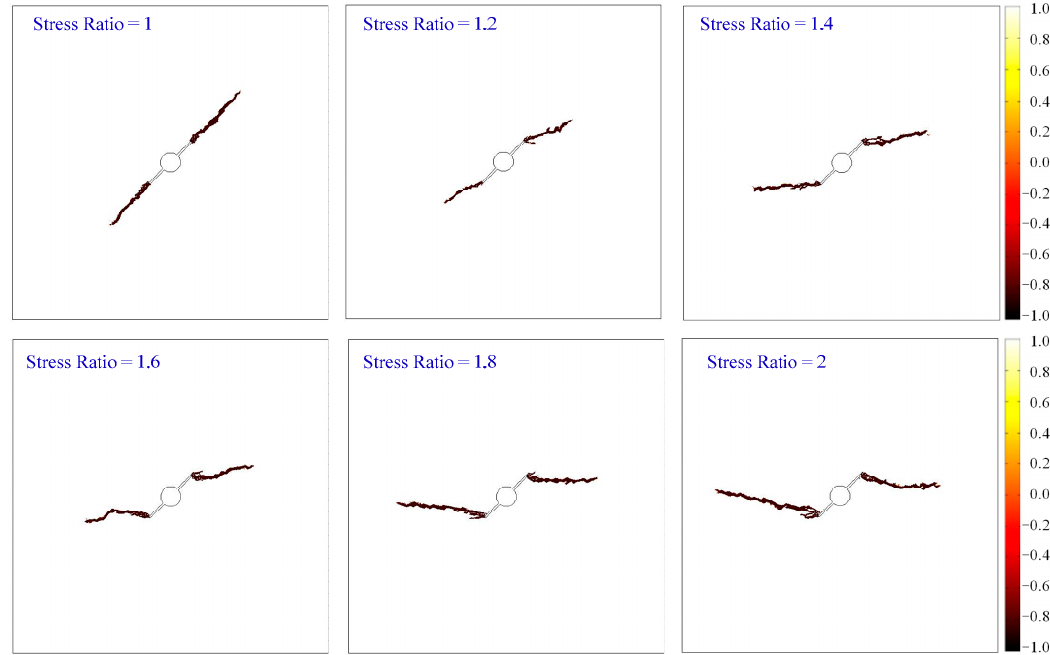
Figure 9. Simulation results of fracture tortuosity/complexity of hydraulic fracturing produced at various stress ratios.